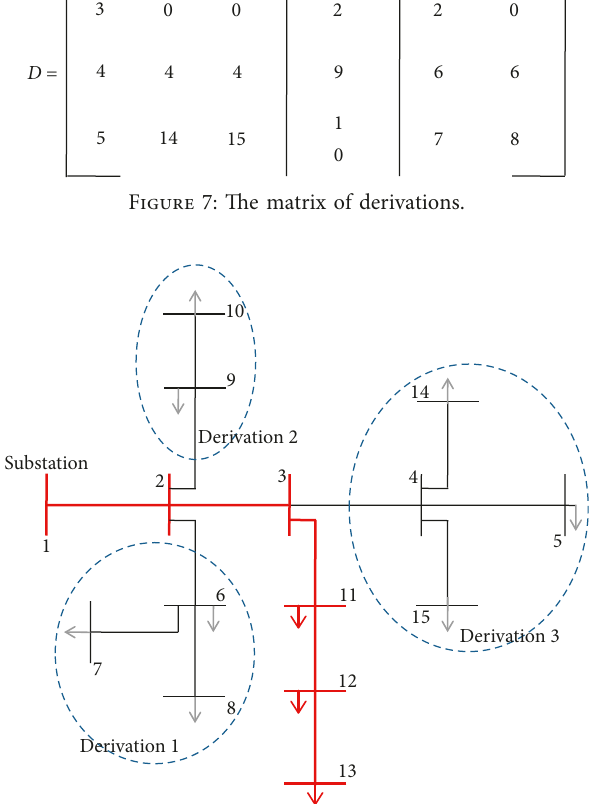
Figure 8: The main line and its derivation of the 15-bus